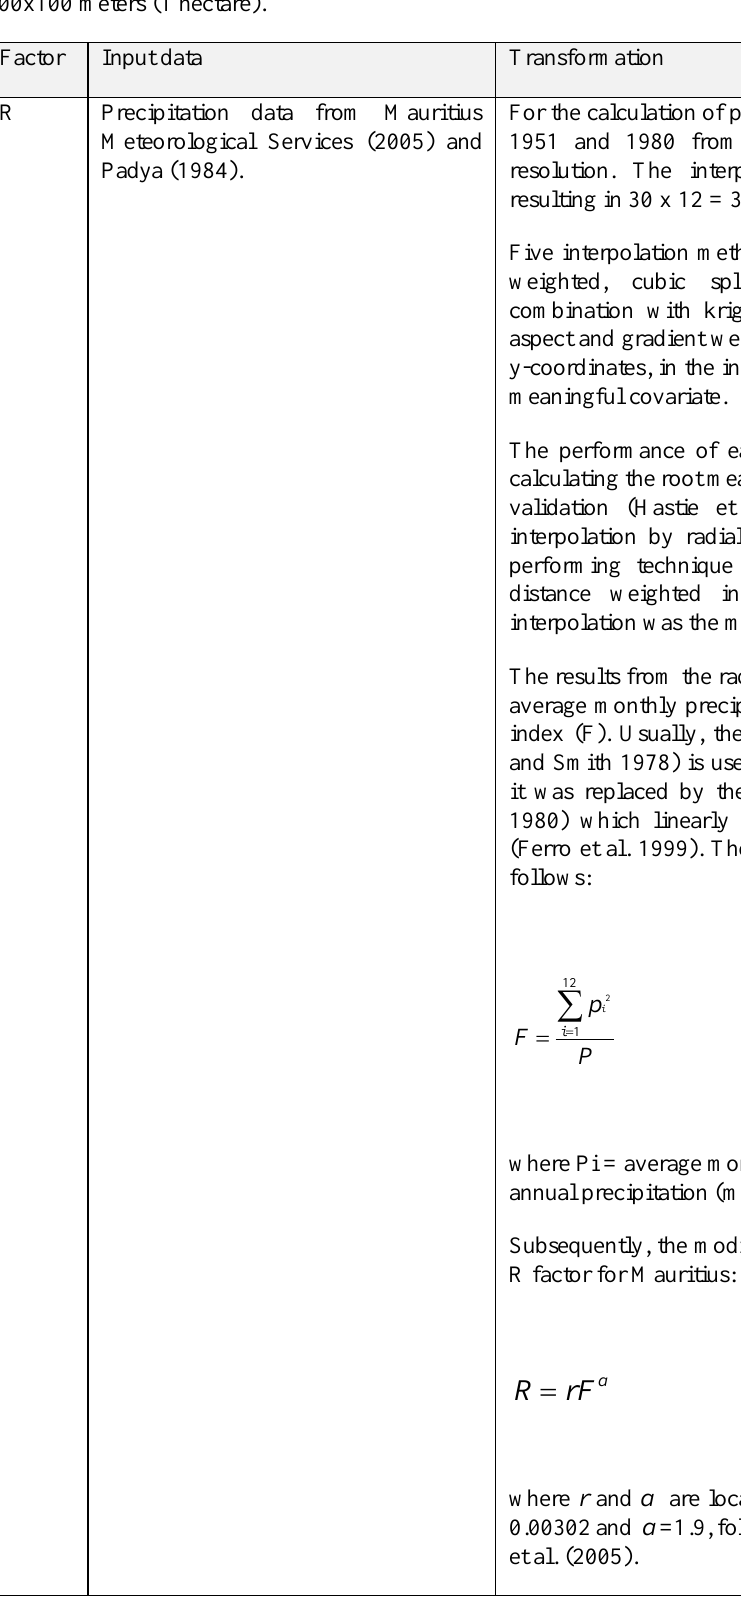
Table A1.1. Overview of data transformations to develop RUSLE factors. All raster files have a cell size of 100x100 meters (1